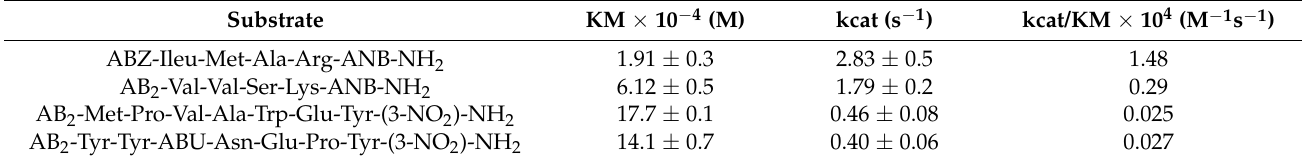
Figure 1. Sequence analysis and phylogeny of Clostridium -producing proteases. ( a ) Structure-based sequence alignment of SP-1 and other selected bacterial proteases (UniProt accession numbers: E1S7U4, protease from H. pylori; Q833V7, gelatinase from E. faecalis; A0A1I0FUC9, protease from C. cocleatum and P04189, Subtilisin from B. subtilis ). The structural elements shown above the alignment were generated using the Subtilisin structure (PDB ID: 6O44). Invariant residues between sequences are typed red on a white background, and conserved residues are shown as white letters on a red background. Green triangles represent conserved amino acids from the catalytic triad, Asp134, His175, and Ser327. ( b ) Distribution of subtilisin-like proteases across gut Clostridium species. Clostridium sequences with >40% identity to SP-1 are clustered into a subclade highlighted in red. Branch labels show bootstrap values. Outer tracks show the numbers of genes from each S8 subtilisin-like protease in each genome. Table 3. Steady-state kinetic